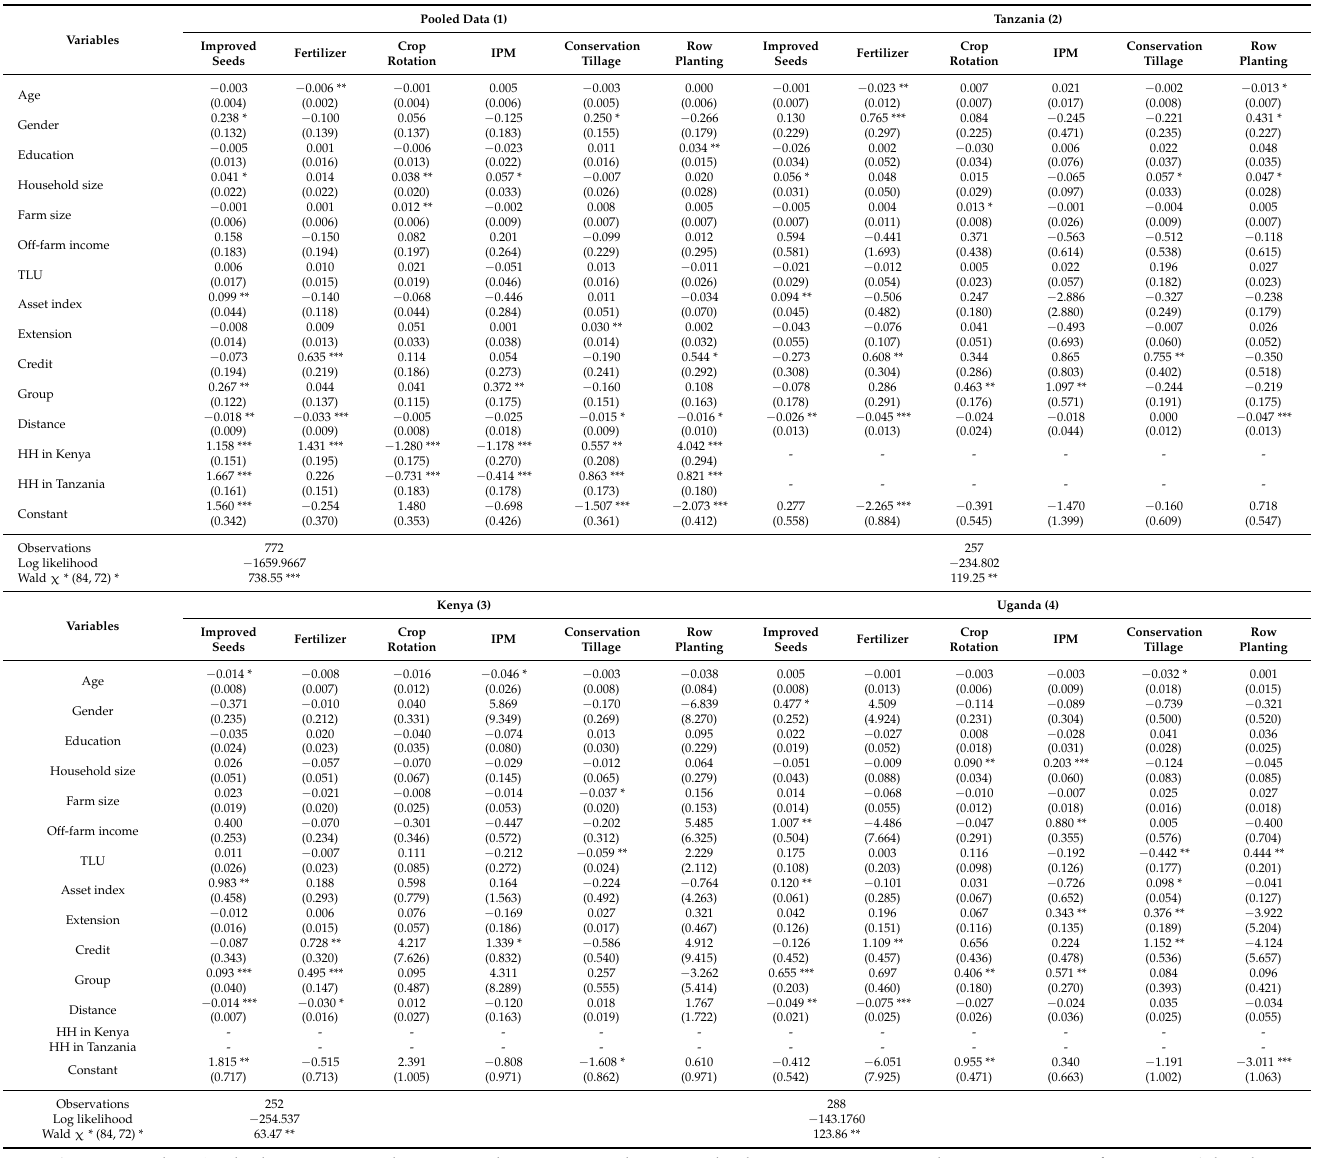
Table 5. Estimates of the MVP